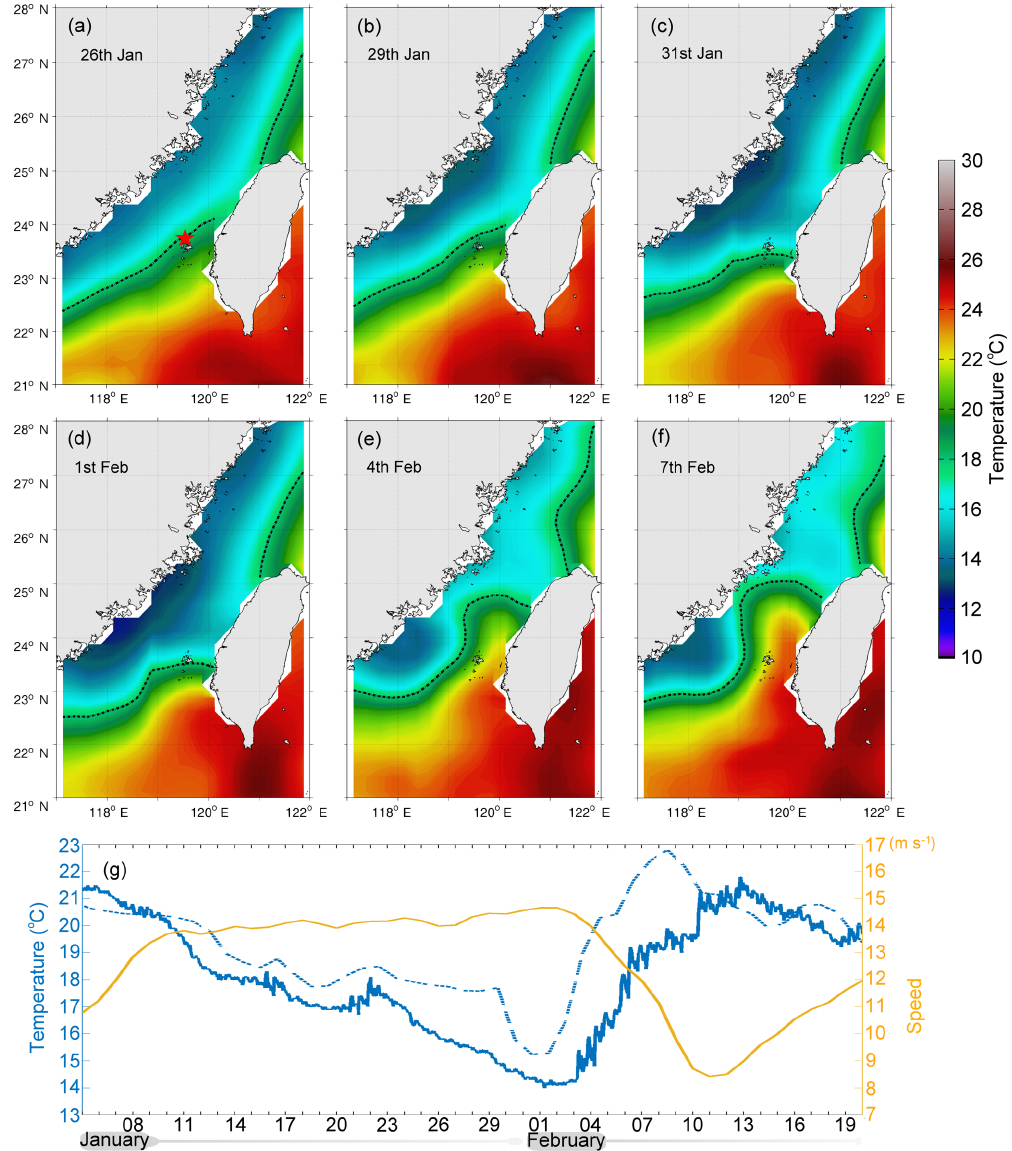
Figure 10. A cold event in the winter of 2011. (a–f) A map sequence of satellite SST. The red star indicates the position of the buoy from the Central Weather Bureau of Taiwan. Dashed lines are isotherm lines of 18 ◦ C. (g) Time series of satellite SST (blue dashed line), buoy SST (blue line), and 10-day AWS (yellow line) on the red star location from 5 January to 20